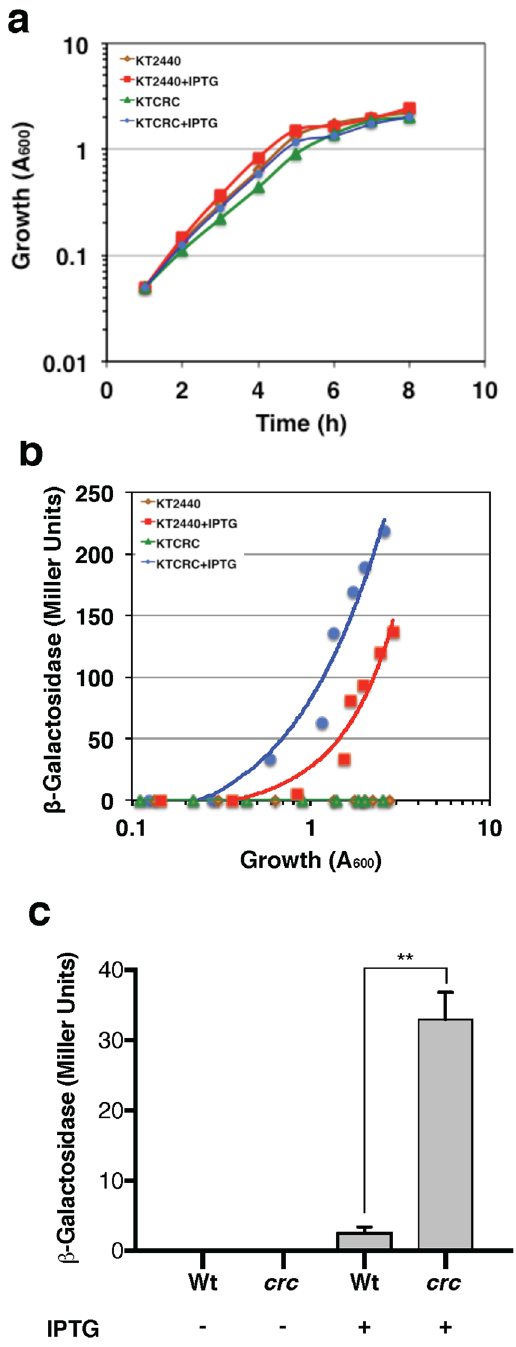
Figure 8. Effect of the Crc protein on the expression of a gluP’-lacZ translational fusion in P . putida . The strains used were KT2440 (wild type) and KTCRC ( crc :: tet ) carrying plasmid pEQ424P ( gluP’-lacZ) . Cells were grown in LB medium and where indicated, expression of the gluP’-lacZ translational fusion was induced from the Ptrc promoter by addition of 0.5 mM IPTG. ( a ) Growth kinetic (measured as the turbidity at 600 nm) of each strain. ( b ) Activity of ß-galactosidase as a function of cell growth. ( c ) ß-galactosidase activity values of the gluP’-lacZ translational fusion observed at a turbidity of 0.6 (mid-exponential phase) for KT2440 or KTCRC strain. Three independent assays were performed, and a representative one is shown. Significant difference was analyzed by t -test. Statistical significance is indicated ( ** p <